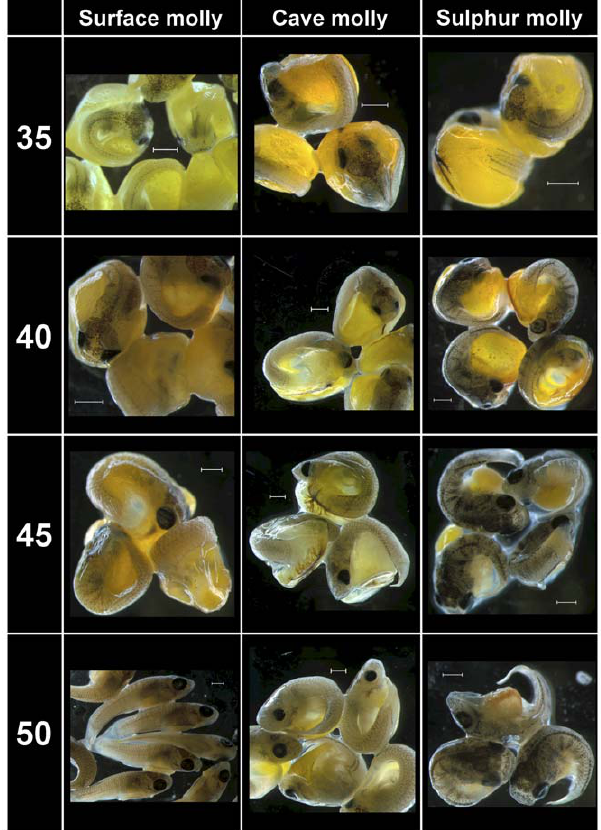
Figure 2. Comparative embryo development of two ecotypes of P.mexicana and of P.sulphuraria . Stages range from Stage 15 to Stage 30. See Table 1 for details. Scale bar = 1 mm.